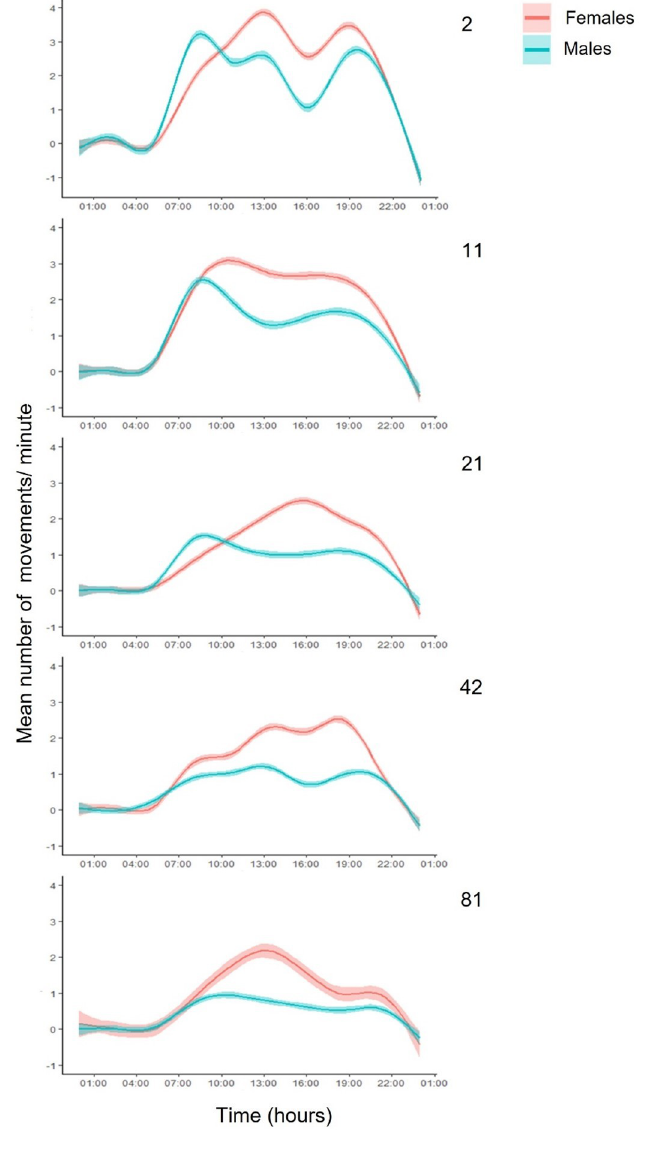
Fig 6. LOESS curves (Locally Estimated Scatterplot Smoothing curves) with 95% Confidence intervals (CI) of the mean 24h locomotory activity for males and females at ages 2, 11, 21, 42 and 81 days.